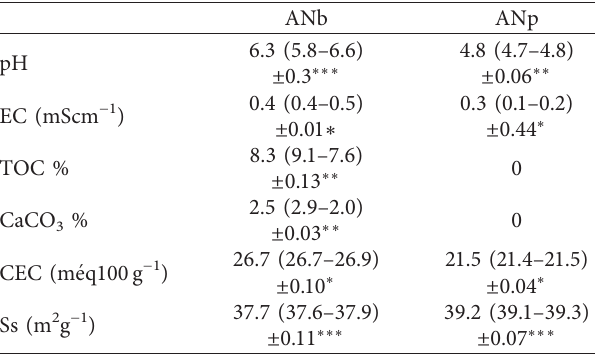
Table 3: Statistic values of the maximum physiochemical pa- rameters of raw and purified clays of Jebel